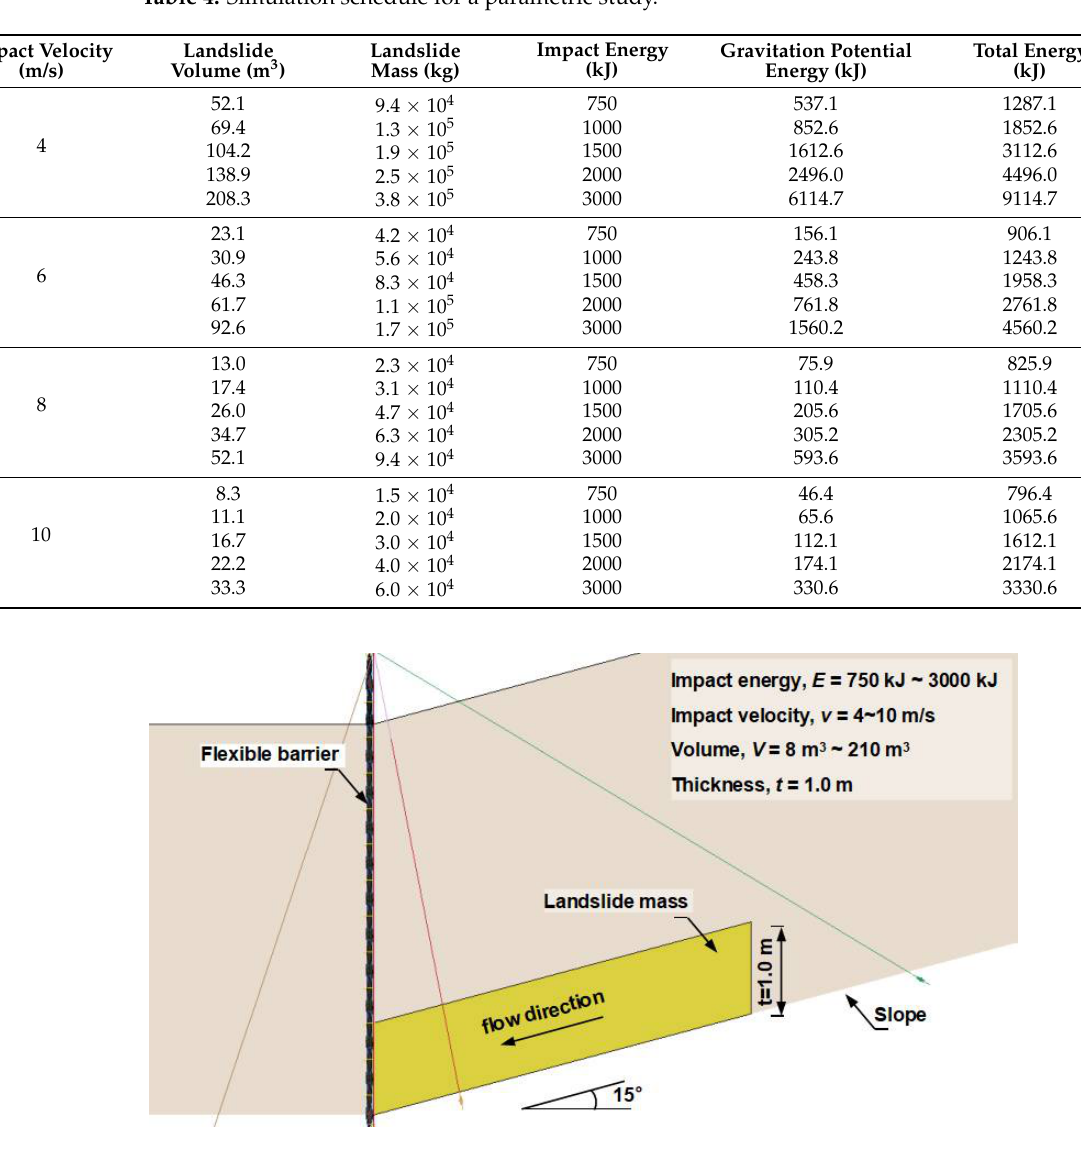
Table 4. The coupled model of the landslide and the flexible barrier is shown in Figure 12.